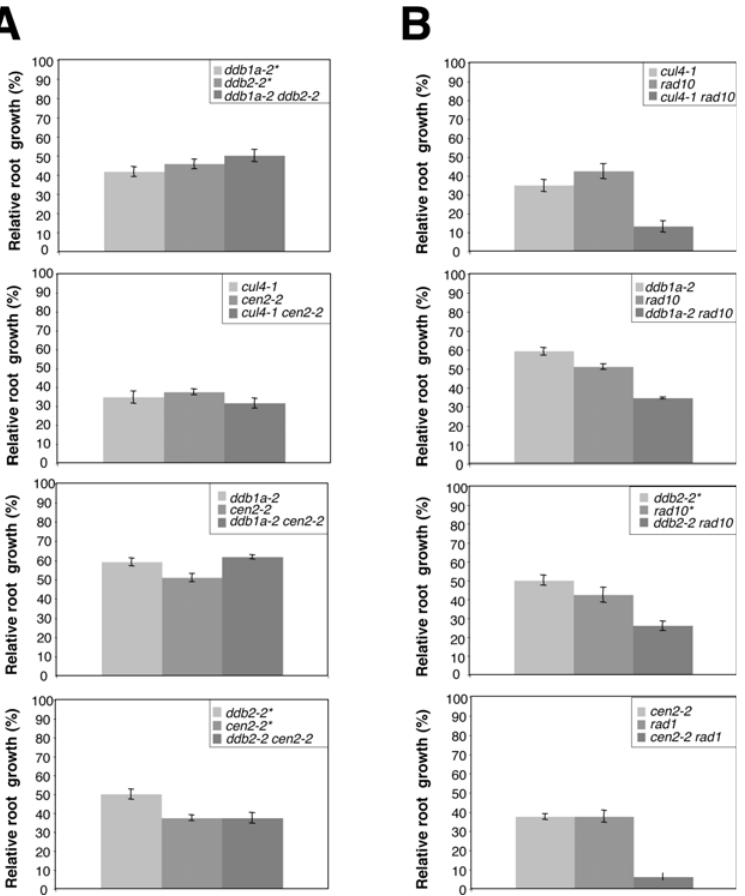
Figure 3. Genetic interactions in NER and HR. One-week-old single and double mutant plants (A) ddb1a-2-ddb2-2 ; cul4-1-cen2-2 ; ddb1a-2-cen2-2 ; ddb2-2-cen2-2 (B) cul4-1-rad10 ; ddb1a-2-rad10 ; ddb2-2-rad10 ; cen2-2-rad1 were exposed to 600 J/m 2 of UV-C. Root growth was measured 24h following irradiation. Root growth was calculated relative to the corresponding untreated plants ( 6 SEM). Eight plants per replicate were used and experiments were triplicated. For all the single and double mutants p , 0.05, compared to WT plants. Because ddb2-2 is in a different Arabidopsis ecotype, the single control mutants were selected as segregants from each double mutant involving ddb2-2 and are indicated by *.